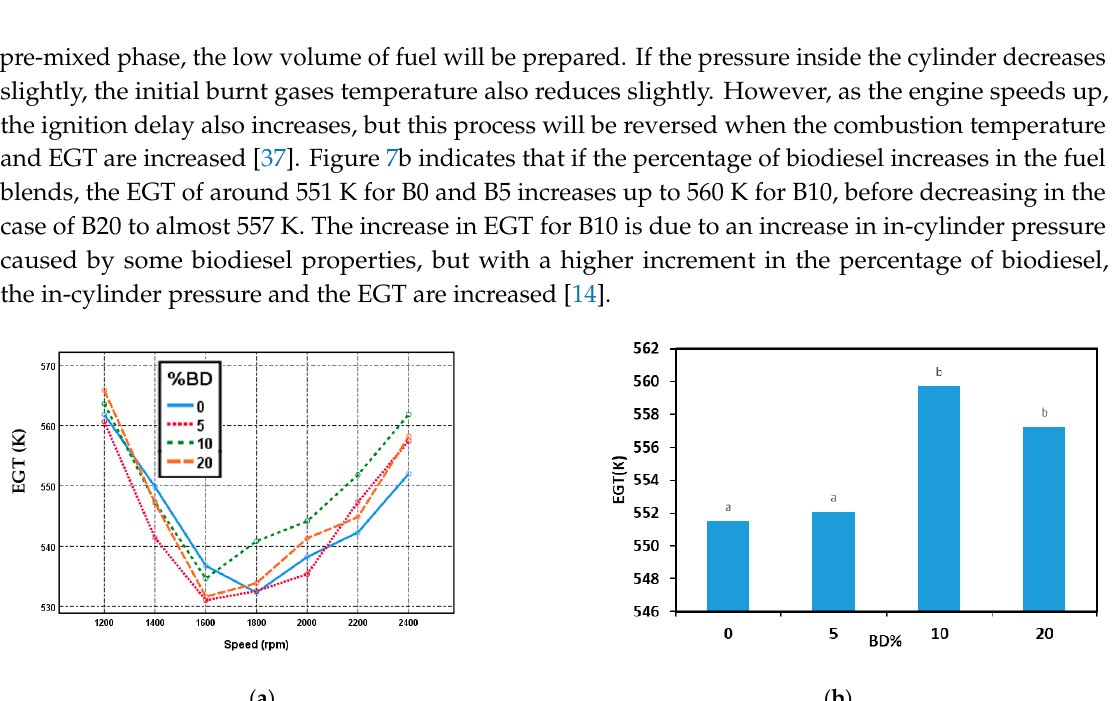
Figure 6. ( a ) Brake specific fuel consumption (BSFC) vs. S at 100% load; ( b ) mean values of total data of BSFC for different speeds and loads. The letters a-d inside the diagram indicate significant differences ( P ≤ 0.05). Figure 7a shows that the enhancement of engine speed at 100% load varies the EGT of all the blends with a similar trend. This means that, as the rpm is increased up to 1600 rpm, EGT declines